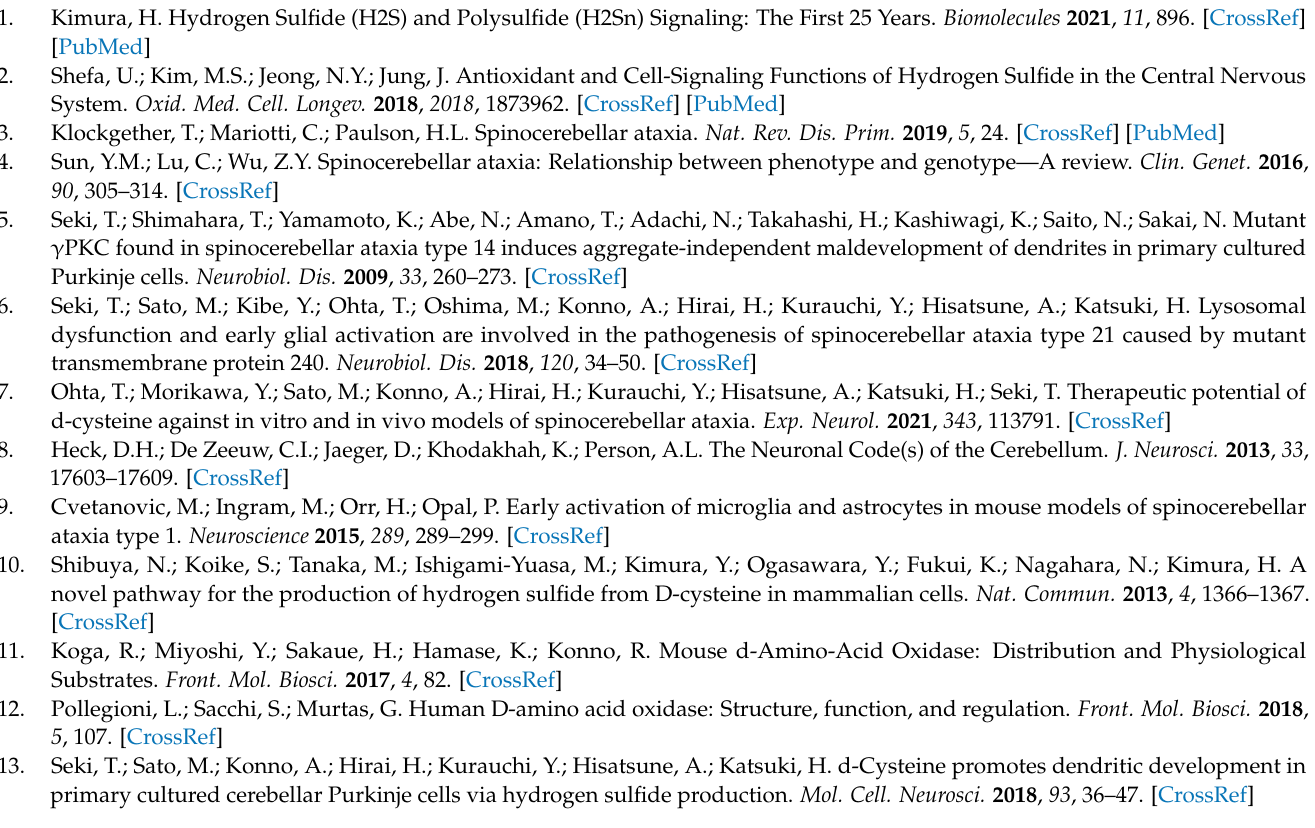
mice. Figure S5: Whole blot images of immunoblot experiments in Figure 7, Figure S6: Whole blot images of immunoblot experiments in Figure